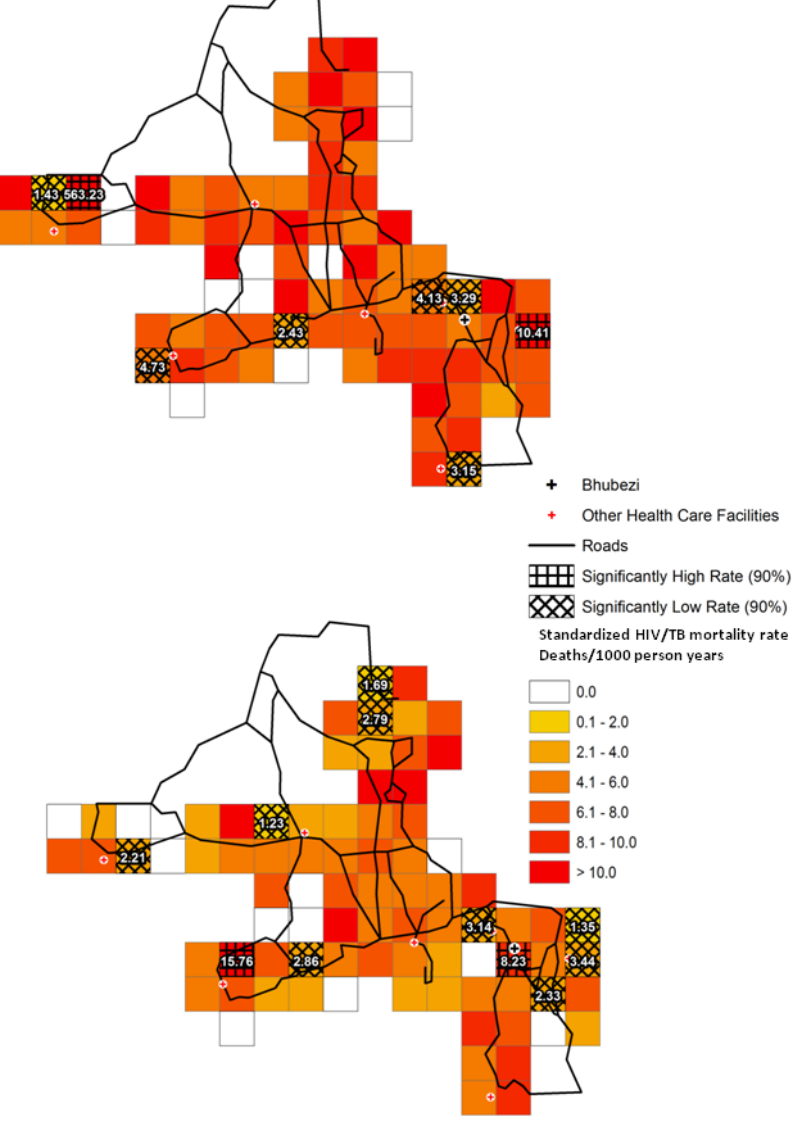
Figure 5. HIV/TB mortality rates (deaths per 1000 person-year, PY) from 2007 to 2008 (upper panel) and 2009–2010 (lower panel) in 2 km grid squares for the Agincourt HDSS site. For grid squares with significantly low rates, the upper bound of the 90% confidence interval is less than the mean rate. For grid squares with significantly high rates the lower bound of the 90% confidence interval is greater than the mean rate. The label is the mortality rate for the grid